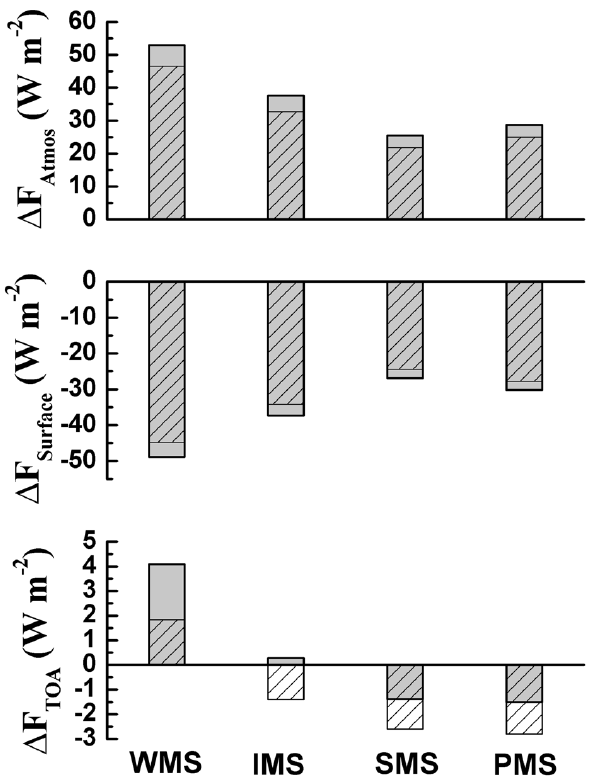
Figure 4. Clear sky aerosol radiative forcing at TOA (bottom), surface (middle) and in the Fig. 4. Clear sky aerosol radiative forcing at TOA (bottom), sur- face (middle) and in the atmosphere (top). Here the shaded portion atmosphere (top). Here the shaded portion corresponds to the radiative forcing estimations corresponds to the radiative forcing estimations without considering without considering the uncertainty in aethalometer measurements and the hashed portion the uncertainty in aethalometer measurements and the hashed por- tion corresponds to the estimations after considering the 20% over corresponds to the estimations after considering the 20% over estimation by aethalometer. estimation by